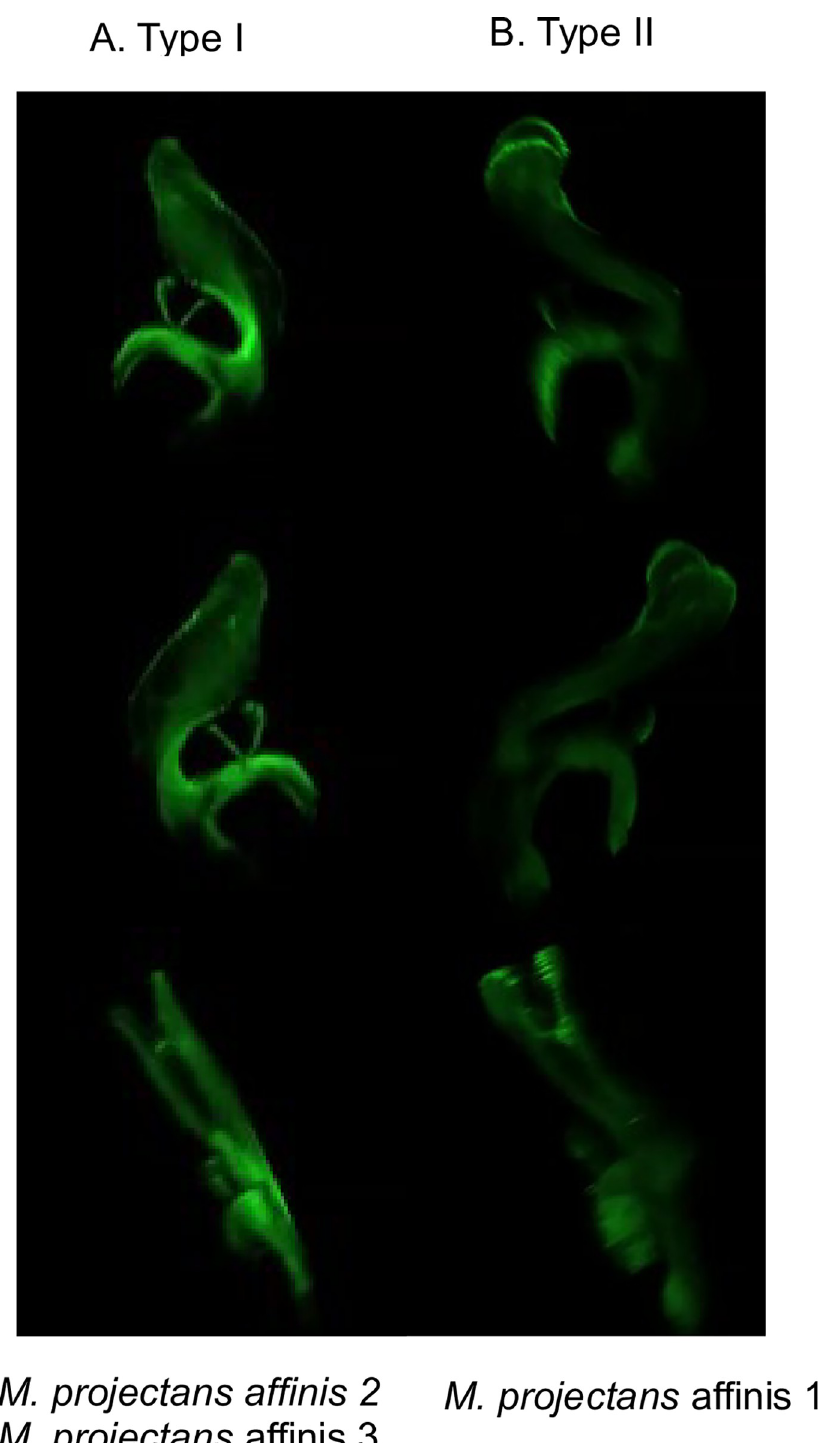
Fig 3. Images of the aedeagus structures reported for the different species of the M . projectans complex as visualized by confocal miscroscopy. (A) Type I, encountered in M . projectans affinis 2 and M . projectans affinis 3; (B) Type II, detected for M . projectans affinis 1. From top to bottom: lateral, dorsolateral, and ventral views. Images (A) of sample 584A35 and (B) of sample 584A39 (see S7 Table for more details).